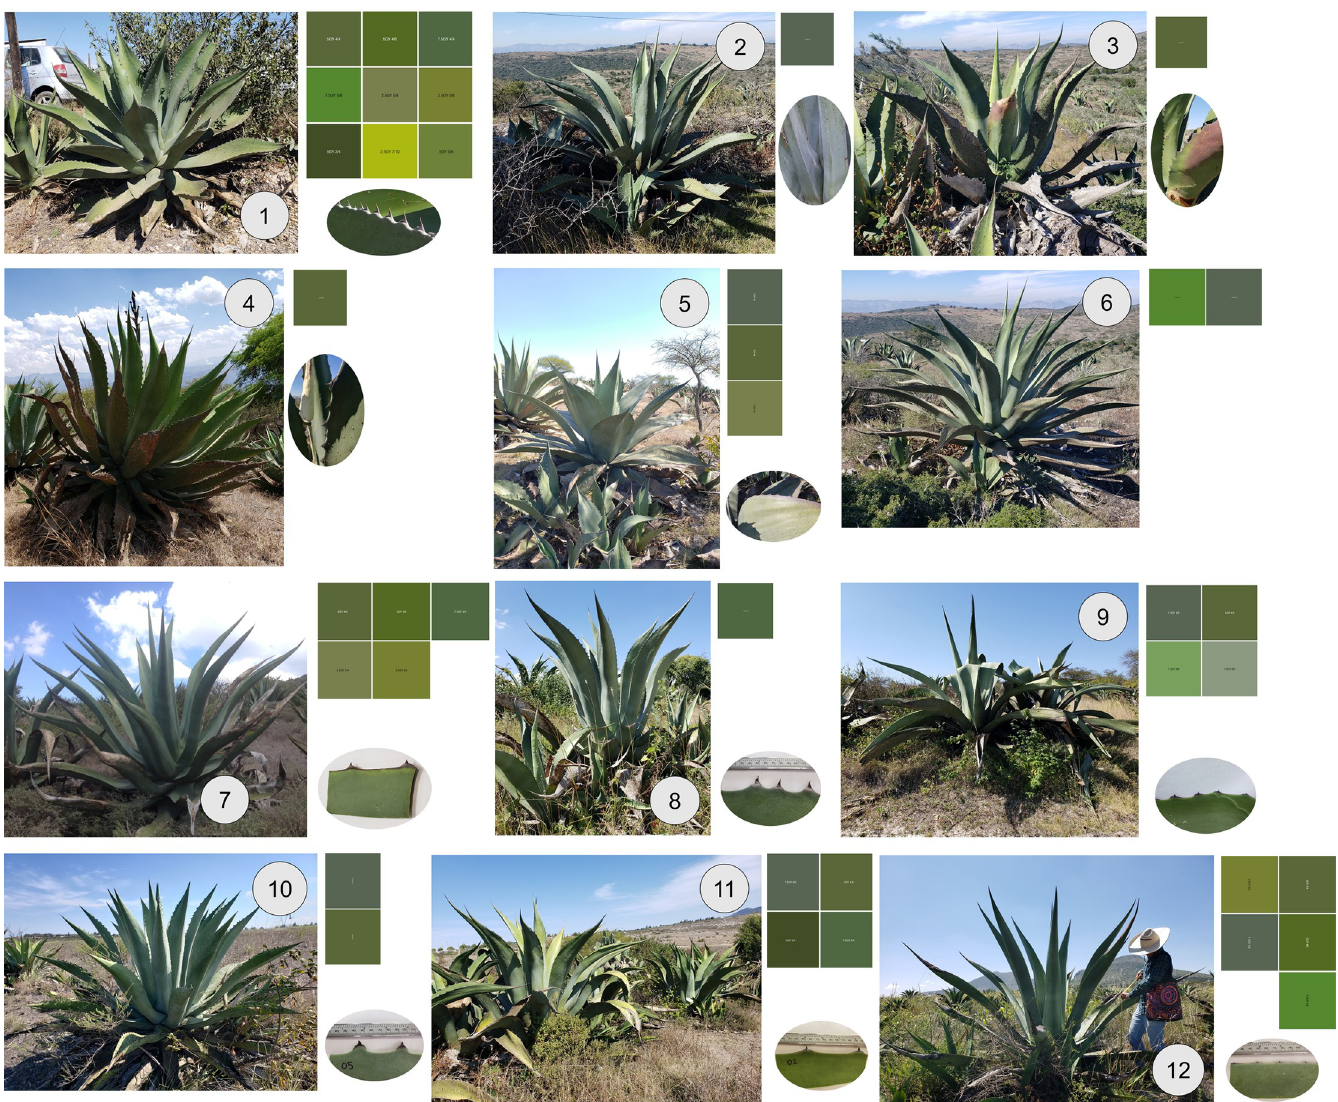
Fig 2. Traditional varieties of pulque agave recorded in the study localities in the state of Hidalgo 1) Corriente , 2) Corriente cenizo , 3) Corriente colorado